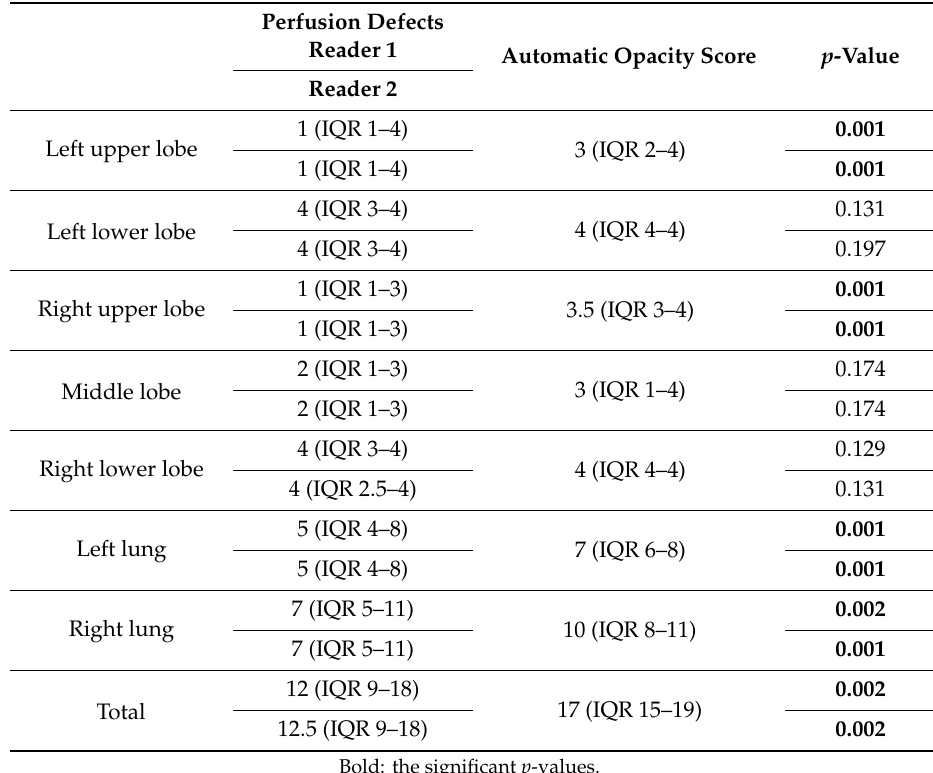
Figure 4. Median perfusion defect scores of reader 1 are displayed in green. Automatic opacity score is shown in